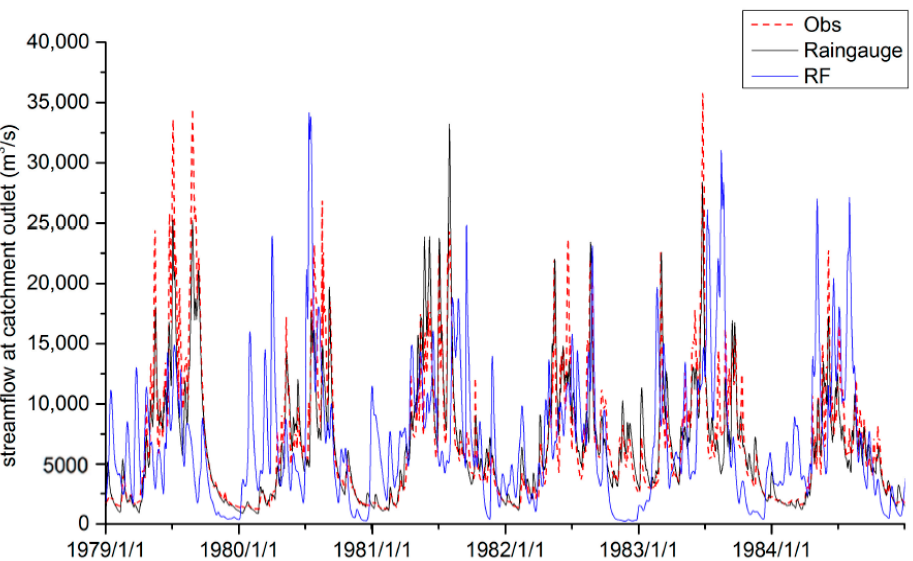
Figure 8. Comparison of flow simulation in the LXH model driven by historical rainfall from climate models and rain gauge measurements.